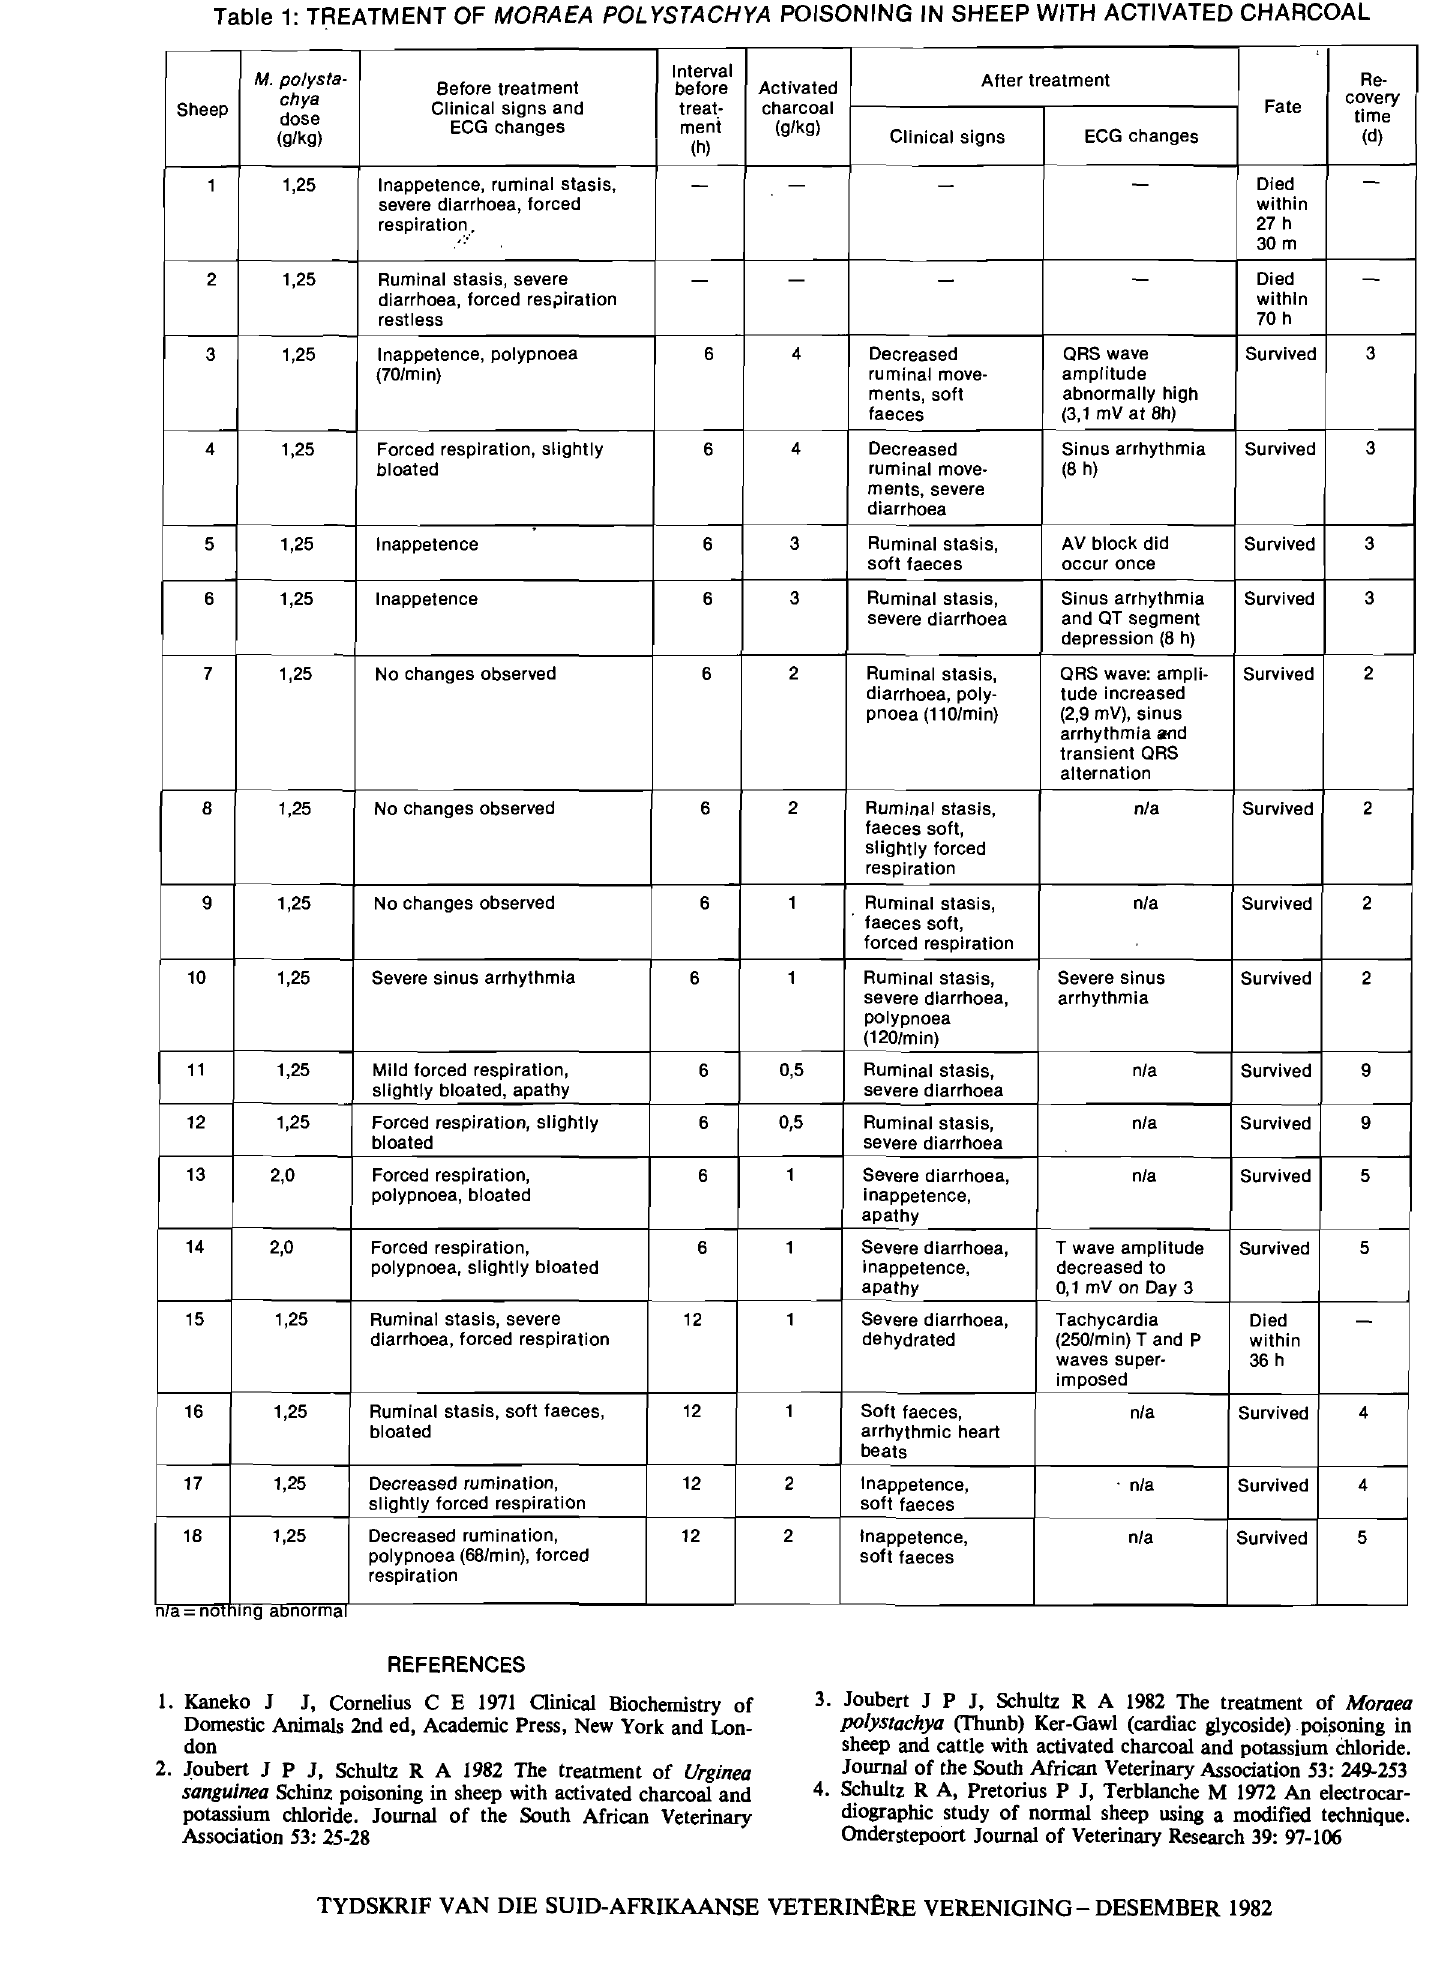
Table 1: TREATMENT OF MORAEA POLYSTACHYA POISONING IN SHEEP WITH ACTIVATED CHARCOAL M. polysta- Interval Before treatment before Sheep chya Clinical signs and